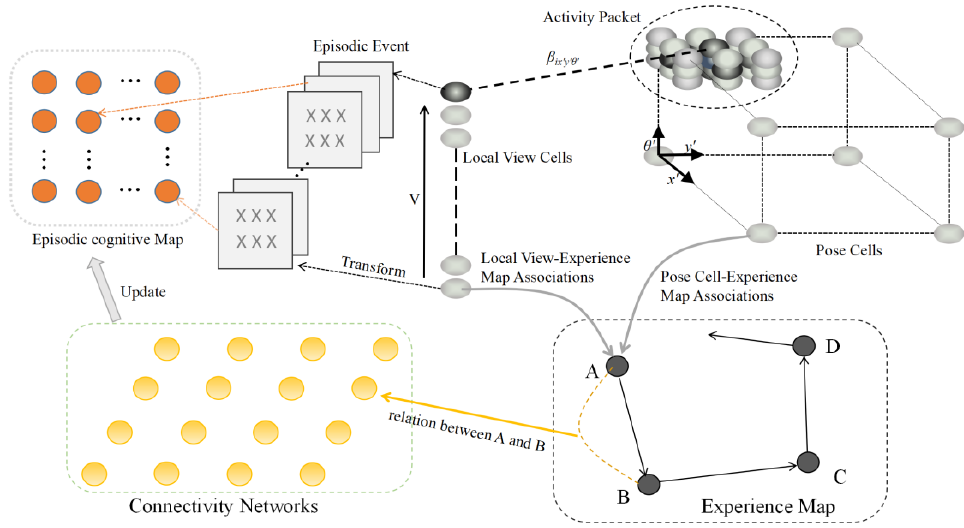
Figure 3. The architecture of the connectivity network, episodic memory and RatSLAM system.